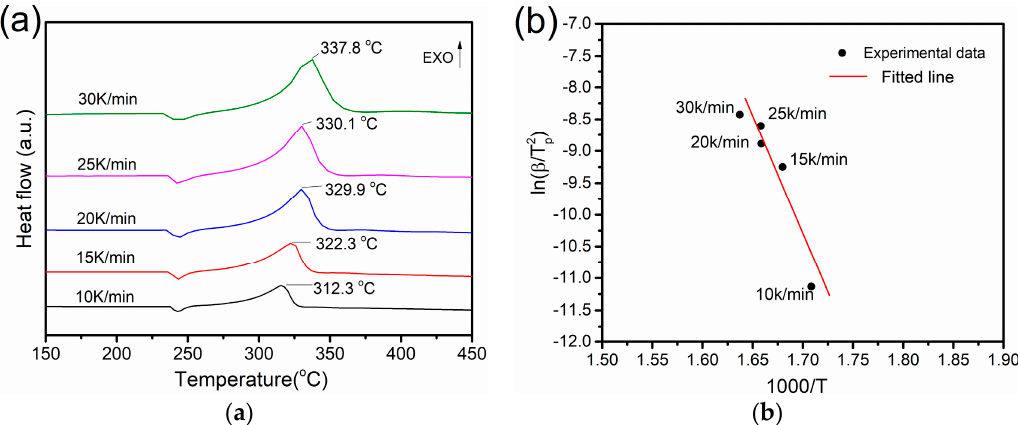
Figure 8. ( a ) DSC curves of AP mixed with as-prepared NiCo 2 O 4 nanowires and pure AP at different heating rates; ( b ) the plot of ln( β /T p2 ) as a function of 1/T p .